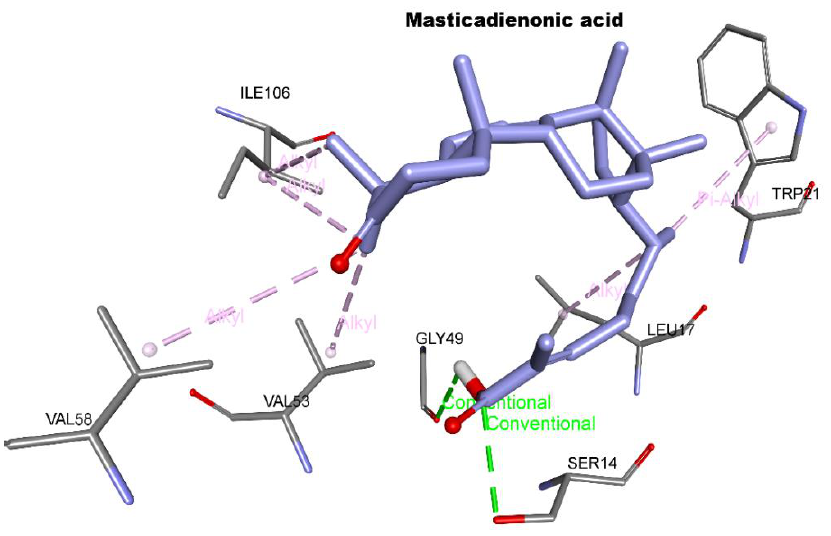
Figure 2. Best pose of docking for Masticadienonic acid in the catalytic site of trypanothione reductase. It should be noted that TRis a key enzyme in the redox trypanosomatid metabolism when its structure is identical for all the characterized species of Trypanosomatidae (67% similarity of primary sequence from Trypanosomatidae, 82% identity between Leishmania spp., and >80% among Trypanosoma spp.) [37], such as those of T. cruzi , T. brucei , and Crithidia fasciculata [38–40]. TR is a homodimer with double symmetry in which every subunit is constituted by three domains, the interface domain (residues 361–488), the NADPH-binding domain (residues 161–288), and the FAD-binding domain (residues 1–160 and 289–360). The binding site for trypanothione as substrate resides in a large cavity at the interface between both subunits, which is formed by the residues of the FAD-binding domain of one monomer and those of the interface of the second domain. The catalysis mechanism of trypanothione reduction implies that the transfer of two electrons is from NADPH via FAD to the Cys52-Cys57 disulfide bridge. The substrate subsequently binds to the enzyme and Cys52, deprotonated by the His461’-Glu466’ pair, and performs a nucleophilic attack on the trypanothione disulfide bridge that results in the formation of a mixed disulfide. Finally, an attack of Cys57 on Cys52 promotes the release of the reduced substrate [41]. Considering that the residues forming the binding sites for the substrates reach 100% similarity, the ligand-binding mode is the same for all TRs characterized so far [37,42]. Thus, this result proves to be important in the treatment of all diseases linked to Trypanosomatidae species. Those parasites lacking this enzyme are avirulent and highly sensitive towards reactive oxygen species [43]. Moreover, re- ducing this enzyme activity to 50% or less of normal ranges decreased the ability of sev- eral Leishmania spp. to proliferate within activated macrophages [44–46]. This fact makes TR an attractive target for the development of new potential drugs. An additional prop- erty that makes TR a potential therapeutic target for antiparasitic drugs is its significant structural divergence from glutathione reductase, the enzyme with the equivalent func- tionality in humans [47–49].